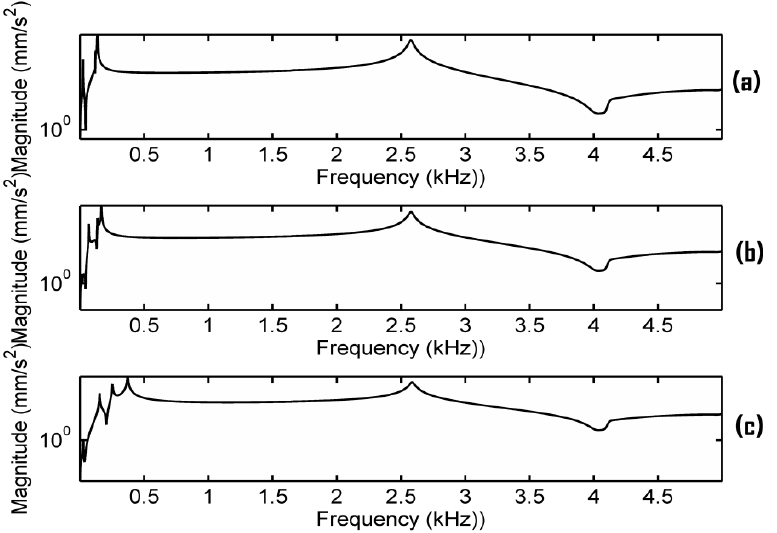
Figure 9. Frequency responses of the bridge in Figure 1a under different contact stiffness with the damping ratio 0.7% critical when EPS1 = 0.01 and ( a ) C C = 1.71, C = 3.87; ( b ) C A E C = 108, C = 171 and C D A